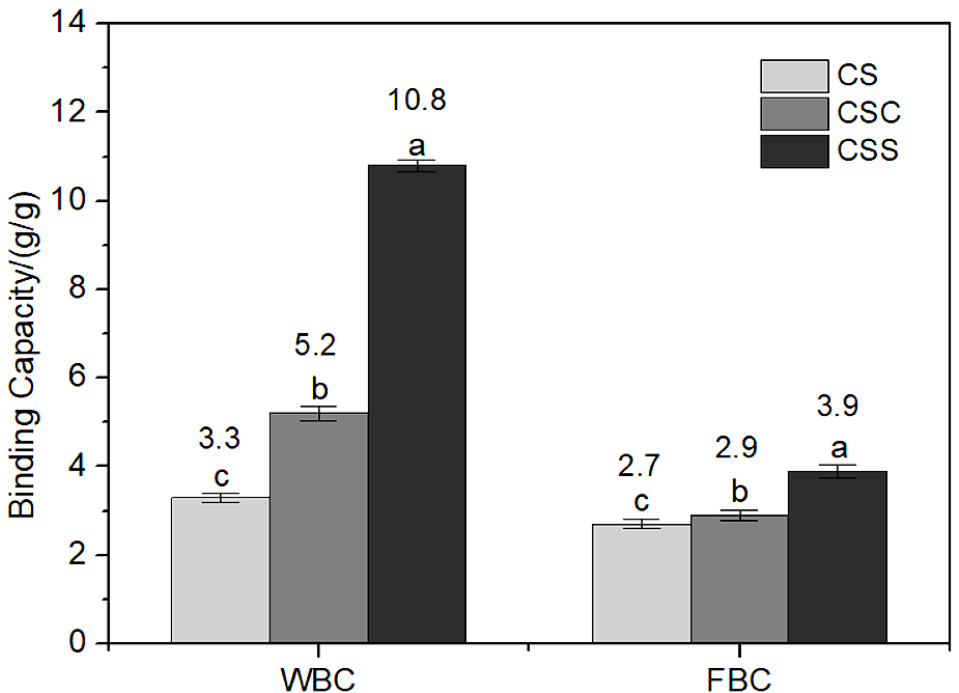
Figure 3. Water-binding capacity (WBC) and fat-binding capacity (FBC) of chitosan. Different small letters under the data in the same group indicate significantly different (p < 0.05).